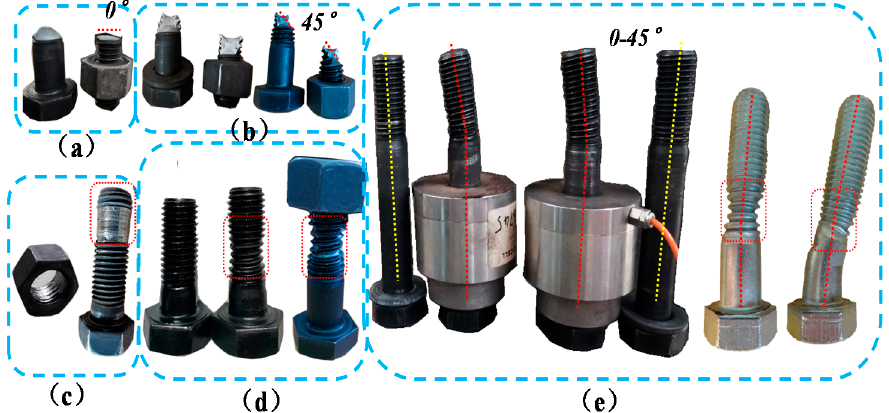
Figure 9. Various deformation forms of bolts: ( a ) Tensile failure; ( b ) Bolt oblique shear failure; ( c ) Bolt thread worn failure; ( d ) Bolt shank necking failure; ( e ) Bolt shank axis bending and